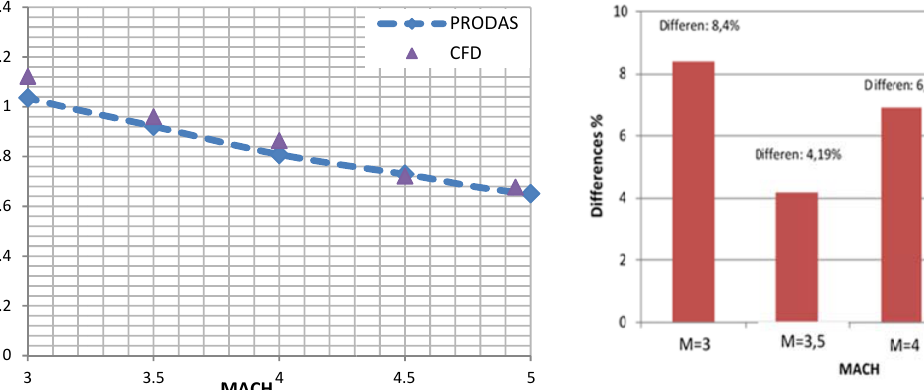
Figure 18. C The pressure the free stre oblique shoc behind the p During supe causes the s supersonic f circular mo characterized change disc large. In fron